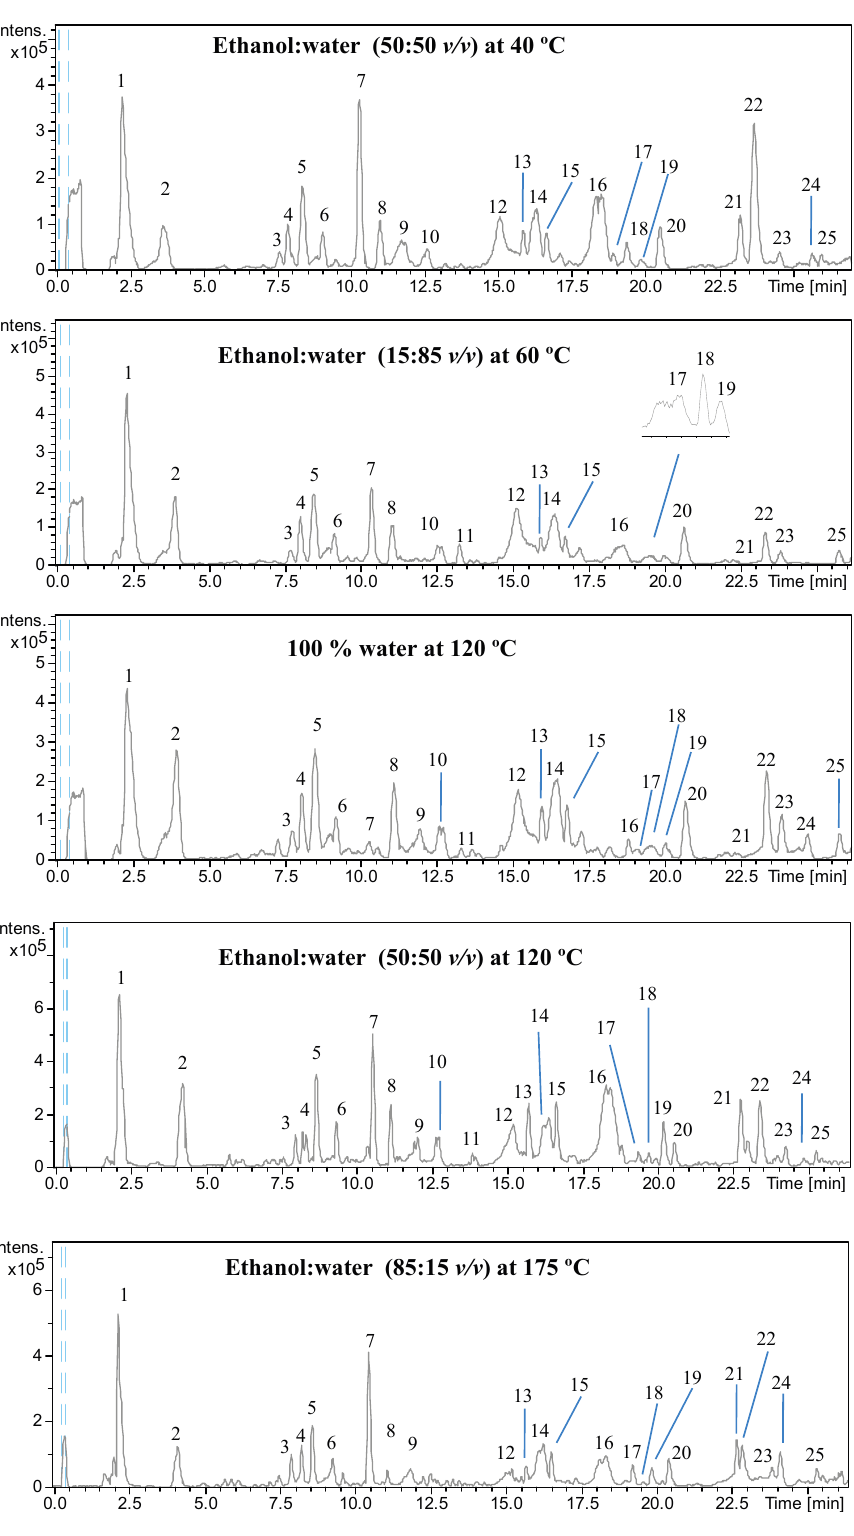
Figure 1. Base peak chromatogram (BPC) obtained from the high-performance liquid chromatography coupled to diode array detection and electrospray time-of-flight mass spectrometry (HPLC-DAD-ESI-TOF/MS) analysis of the filter cake extracts obtained under different PLE extraction conditions. Peaks have been numbered according to the elution order. For the peak identification, see Table 2. Chromatographic conditions are described in the Experimental